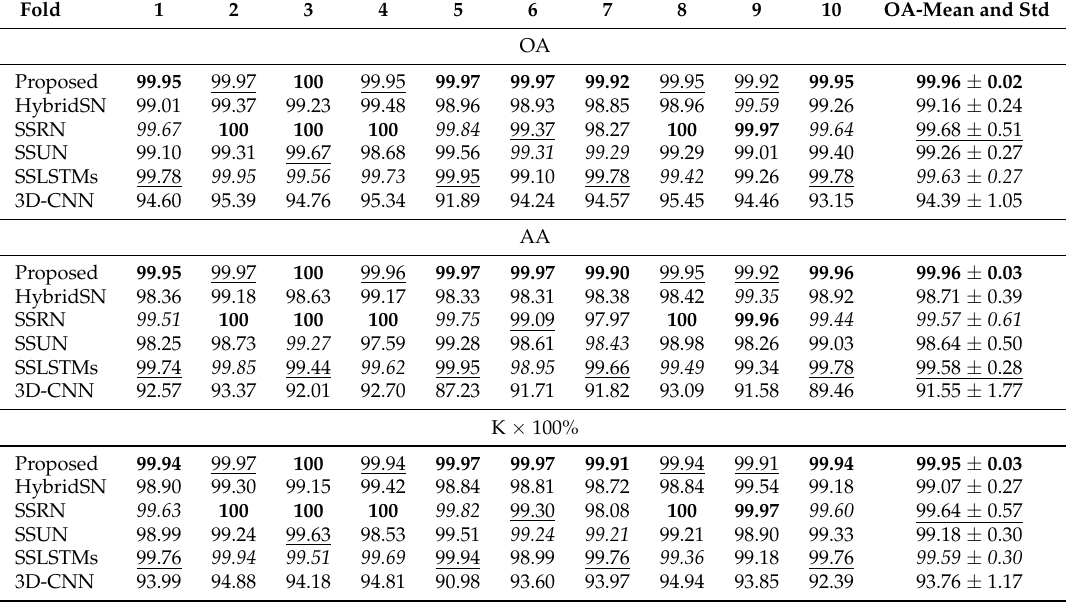
Table 11. Fold Overall Accuracy, Average Accuracy, and Kappa Value on KSC dataset with 30% training data. The best performance is in bold, the second-best performance is underlined, and the third-best is in